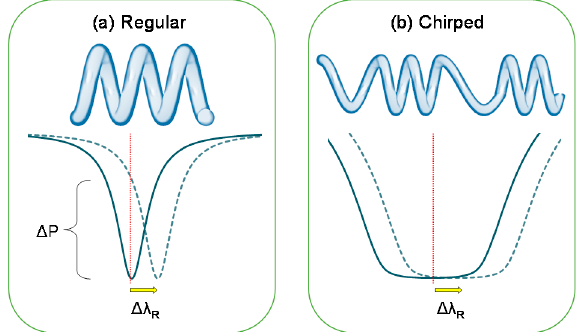
Figure 8. Effect of ambient temperature-induced resonance shift on the transmission spectrum of a: ( a ) 3-turn microfiber coil resonator, and ( b ) 12-turn chirped microfiber coil resonator. The dashed lines facilitate a comparison of the output power before and after the resonant wavelength shift.